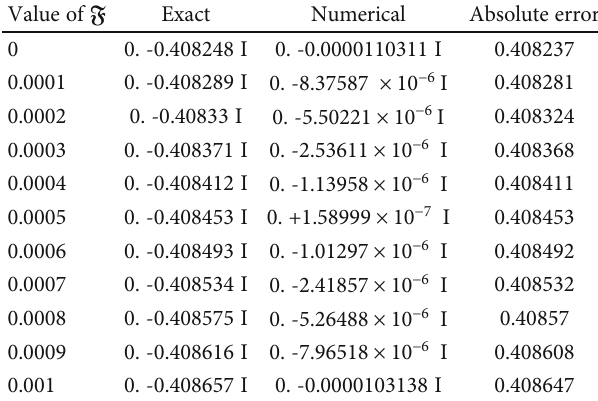
Table 1: Exact and numerical value of the Atangana conformable derivative ( 1 + 3 )-ZK equation with power-law nonlinearity through the obtained analytical solutions via the modi fi ed Khater method Equation (16) and septic B-spline scheme.